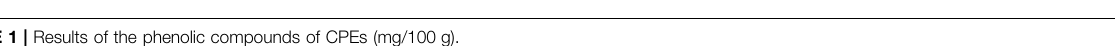
TABLE 1 | Results of the phenolic compounds of CPEs (mg/100 g).